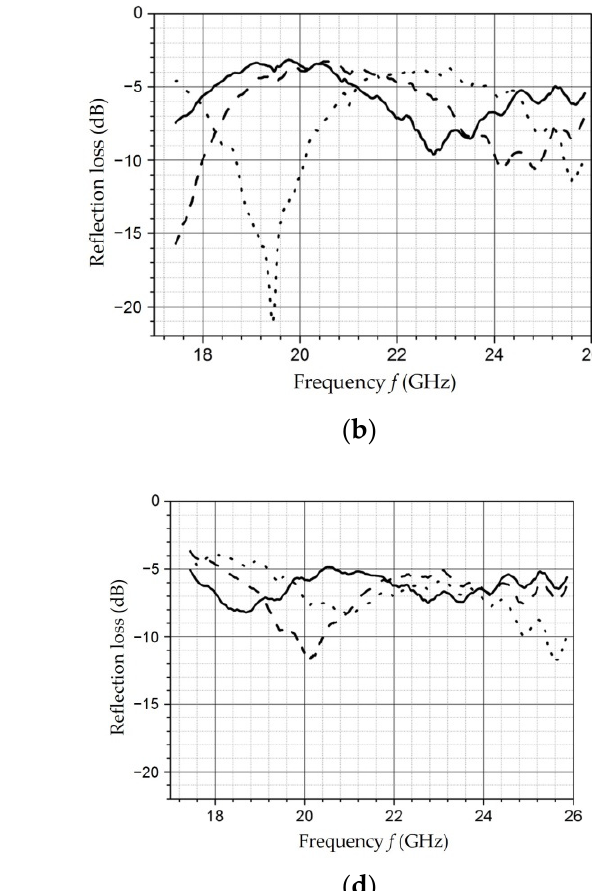
Figure 39. The investigated coating options consisted of two layers of an absorbing com- posite with different mass concentrations of TEG filler 2% and 3% (solid line), 1% and 3% (dashed line), and 1% and 2% (dotted line). As for the underlying dielectric layer with ε ≈ 4–10, the composition of the filler was varied, such as (a) no filler, (b) BaTiO 3 , (c) BaTiO 3 + CG, and (d) BaTiO 3 + AMAG.